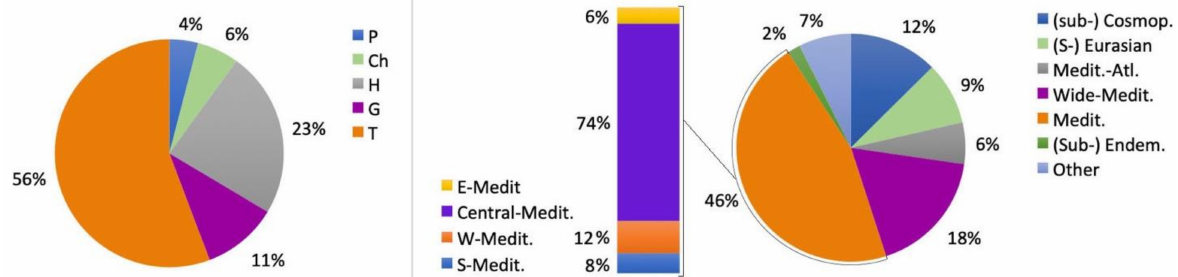
Figure 1. Life form ( left ) and biogeographical status ( right ) of the taxa recorded from the Island of Capo Passero in our survey (see Appendix A). Life form abbreviations: P, phanerophytes; Ch, chamaephytes; H hemicryptophytes; G, geophytes; T,